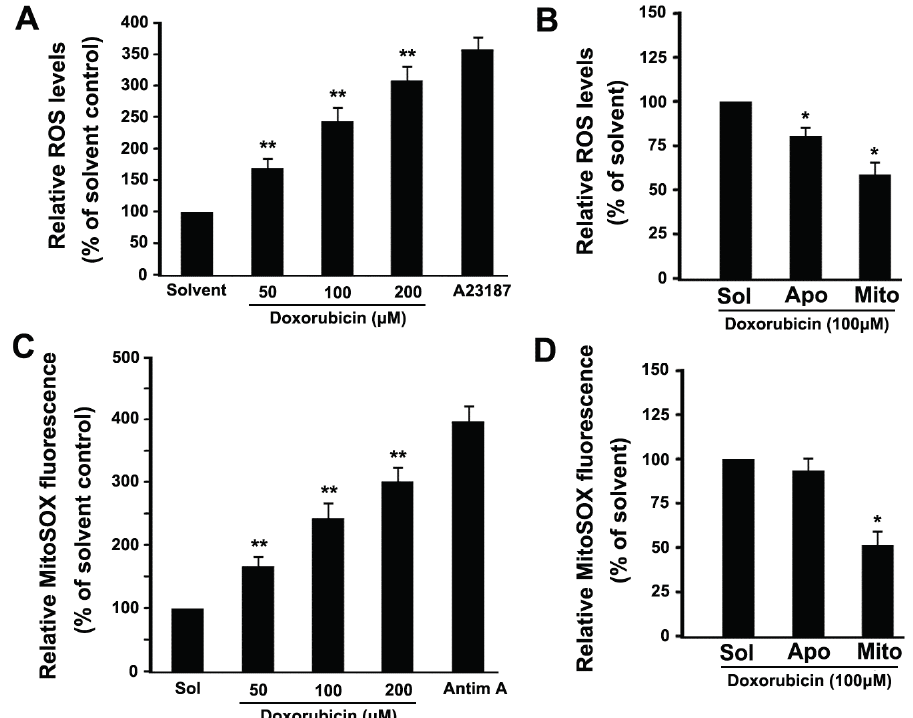
Figure 4. DOX increased intracellular ROS and mitochondrial ROS production. ( A – D ) Platelets were loaded with 2’7’-dichlorofluorescin diacetate (DCFDA) ( A , B ) or MitoSOX™ Red ( C , D ), and incubated with various concentrations of DOX or solvent ( A , C ), or pre-incubated with apocynin, Mito-TEMPO, and then incubated with DOX ( B , D ). (50 μ M) at 37 °C for 30 min. Treated platelets were analyzed for intracellular ROS or mitochondrial ROS levels by flow cytometry. The relative ROS levels are expressed as a percentage of platelets that were incubated with solvent control. Percentage is presented as means ± SEM from three independent experiments. ** p < 0.017 (after Bonferroni correction) as compared with solvent control. * p < 0.025 (after Bonferroni correction) as compared with solvent control. Solvent, apocynin, Mito-TEMPO and Antimycin A are labeled as Sol, Apo, Mito and Antim A,